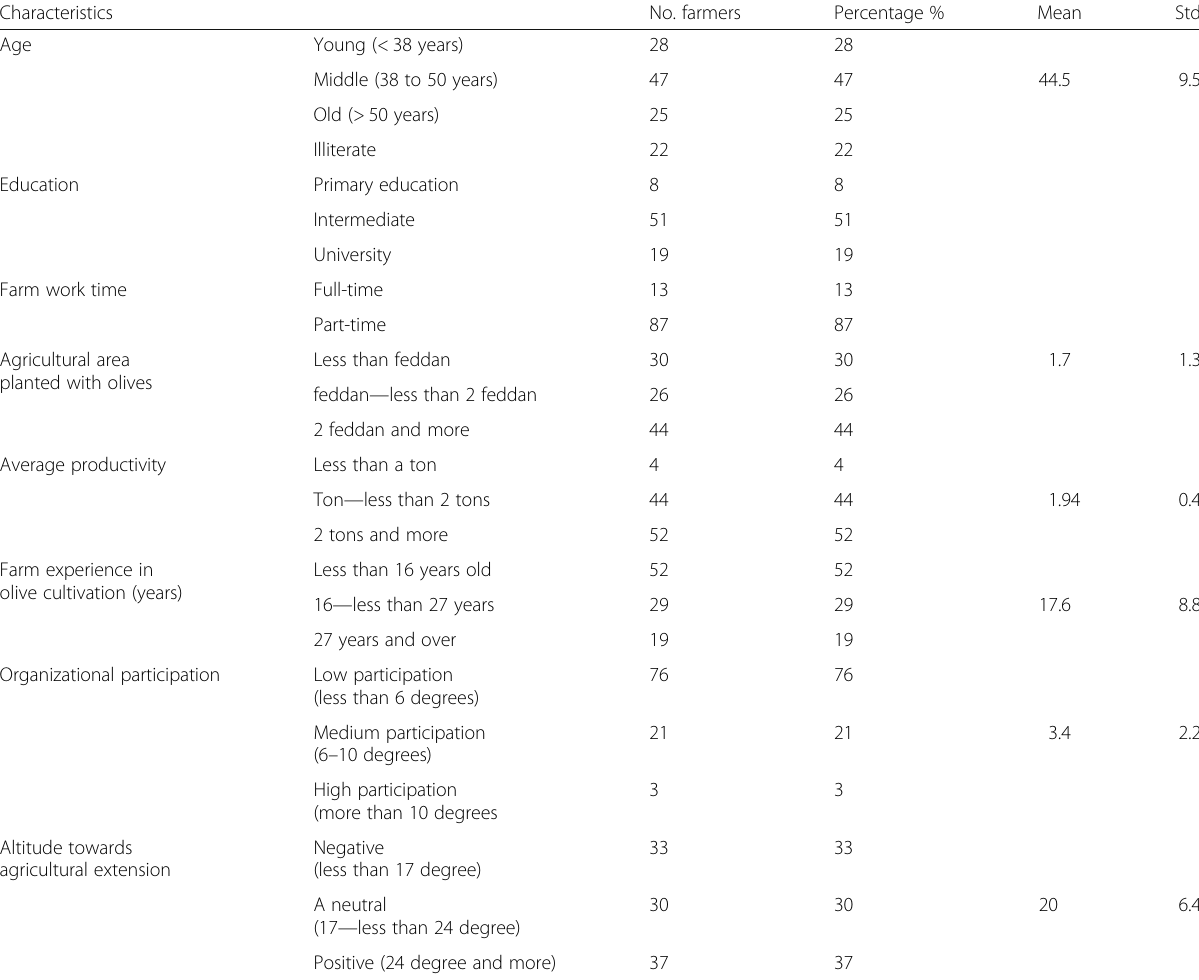
Table 2 Characteristics of participating farmers and their farms